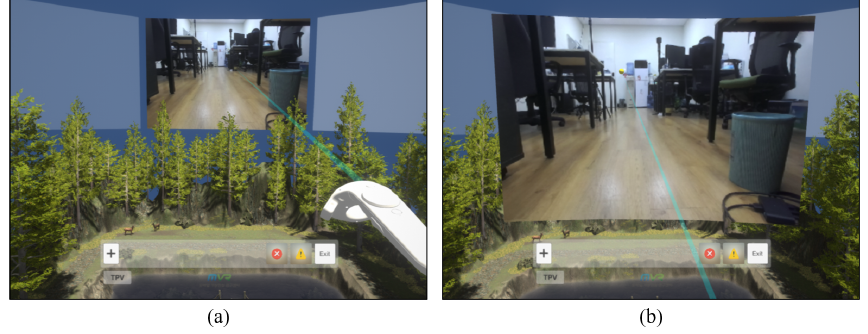
Figure 20. Dot annotation using controller and virtual screen: ( a ) before selection; ( b ) after selection.